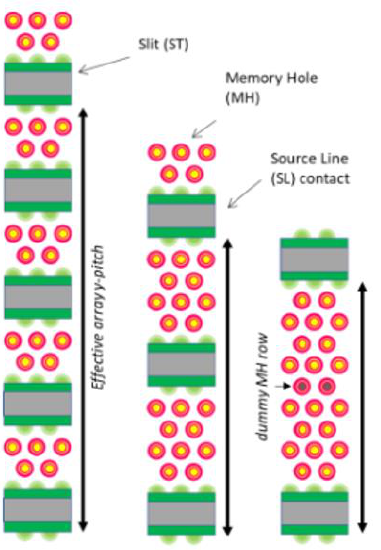
Figure 10. The year-by-year trend of cell layer stacking in 3D NAND published in ISSCC confer- ences. The reverse trend in 2020 is because the publications are about SLC and QLC technologies on the 96-layer NAND baseline.